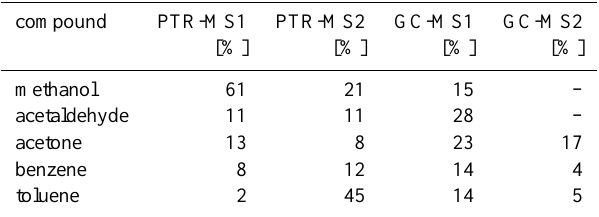
Table 1. Total relative uncertainties of the measured compounds for all the instruments. The uncertainty values of PTR-MS1 and PTR- MS2 are averages of hourly total uncertainties. For GC-MS1 and GC-MS2, the total uncertainties are for one measurement